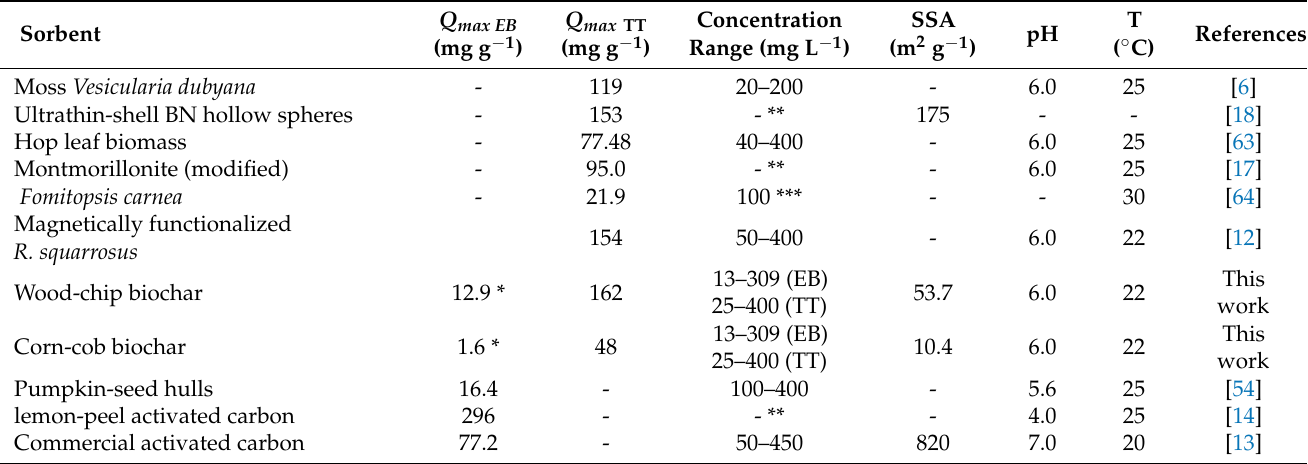
Table 5. The maximal adsorption capacities Q max for EB and TT by various adsorbents calculated using Langmuir isotherm model.